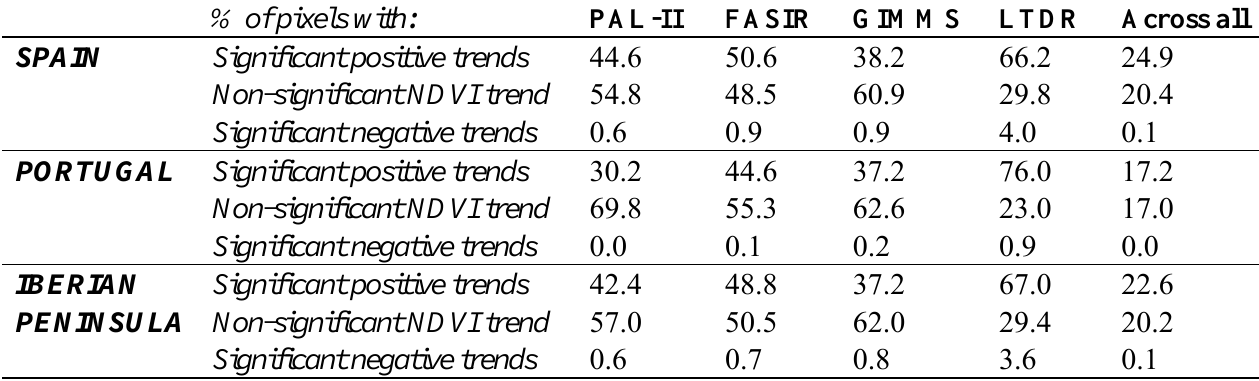
Table 4. Percentage of pixels of Spain, Portugal, and the Iberian Peninsula exhibiting significant NDVI trends (p-value < 0.05) in each AVHRR dataset (PAL-II, FASIR, GIMMS, and LTDR), and percentage of pixels that showed consistent significant (positive, absence, or negative) NDVI trends across all four datasets. Significant NDVI trends were considered for p-values < 0.05 by means of the seasonal Mann-Kendall trend